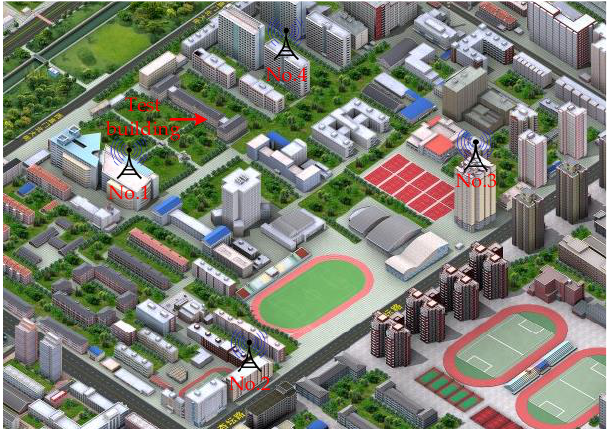
Figure 17. Test environment.